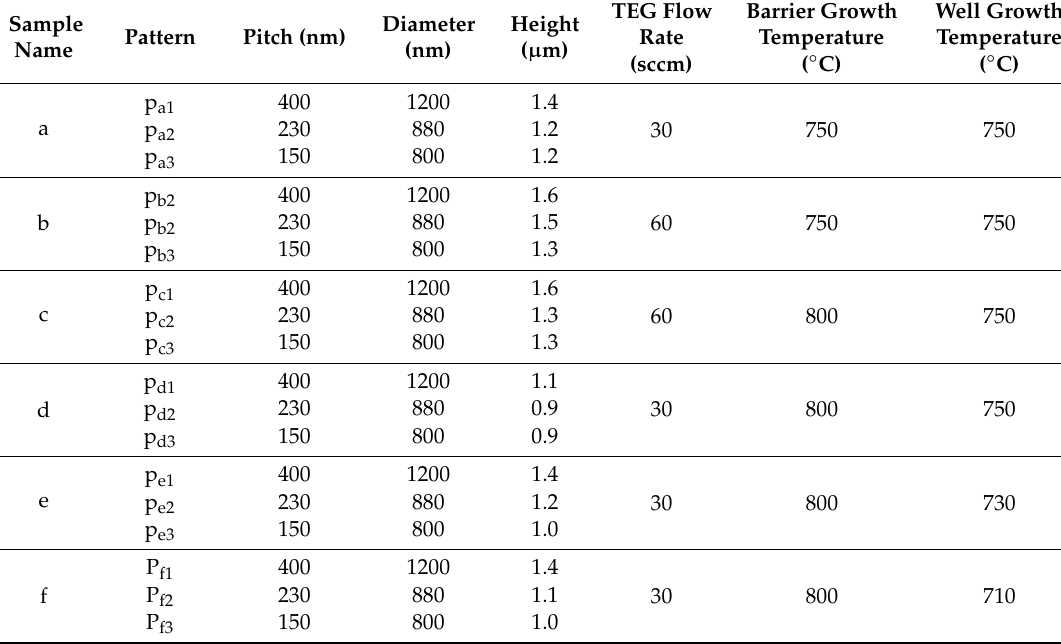
Table 1. Metalorganic chemical vapor deposition (MOCVD) Growth Parameters of the NW Samples.